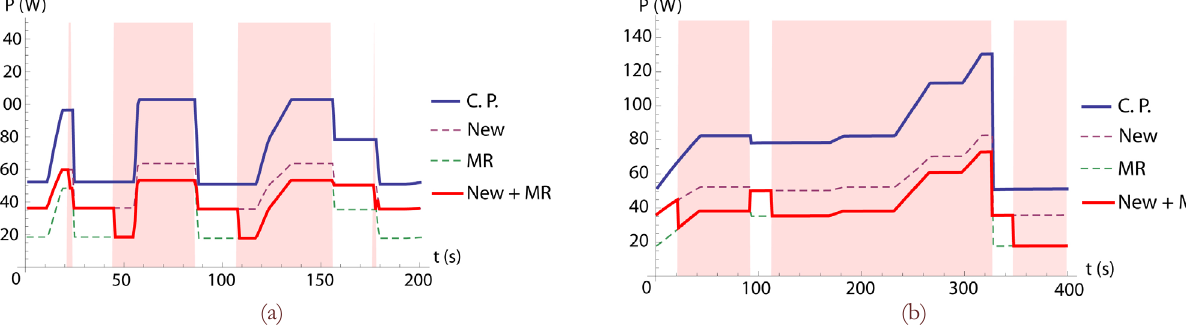
Figure 16: Comparison between power absorbed by current production vacuum pump and integrated clutch-vacuum pump system.